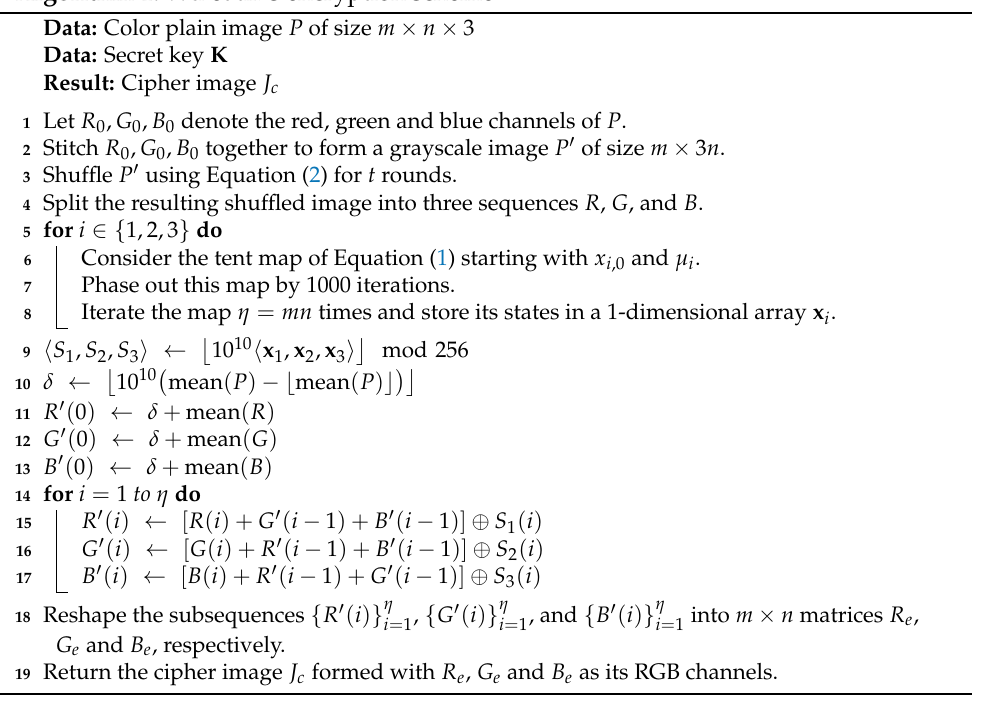
Algorithm 1: Wu et al.’s encryption